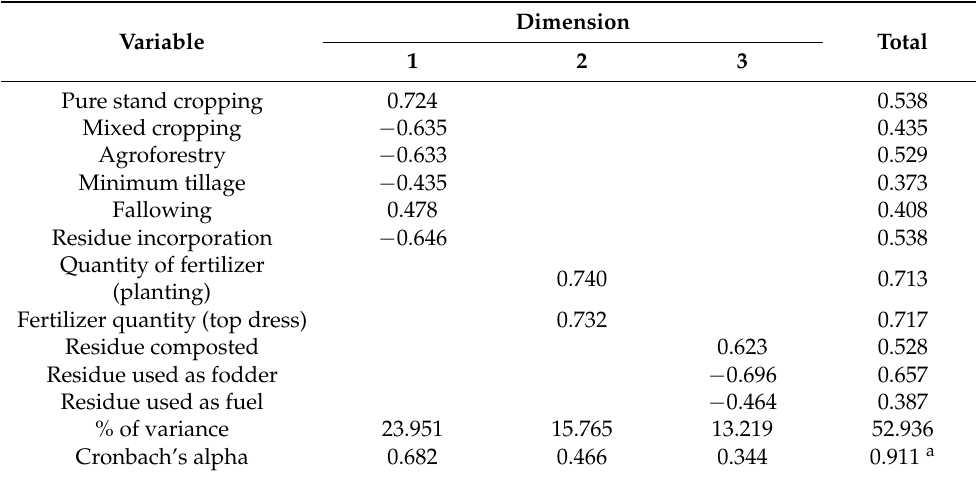
Table 6. Principal component loadings of soil fertility management practices based on CATPCA analysis using variable principal normalization.